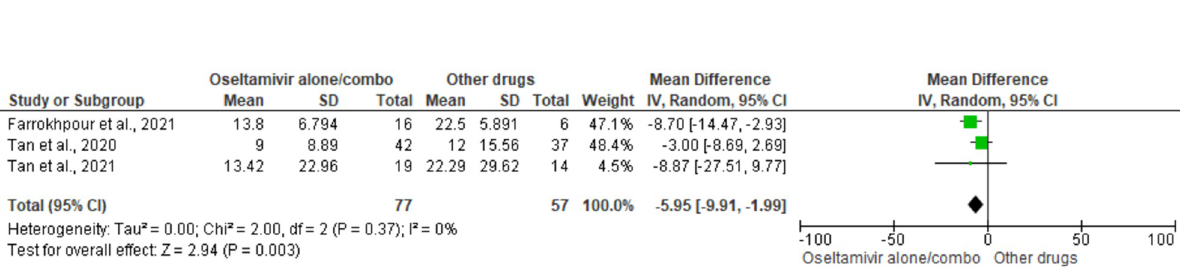
Fig 10. Forest plot. Shows the sensitivity analysis pooled estimate of the duration of hospitalisation of oseltamivir alone/combination vs other drugs.